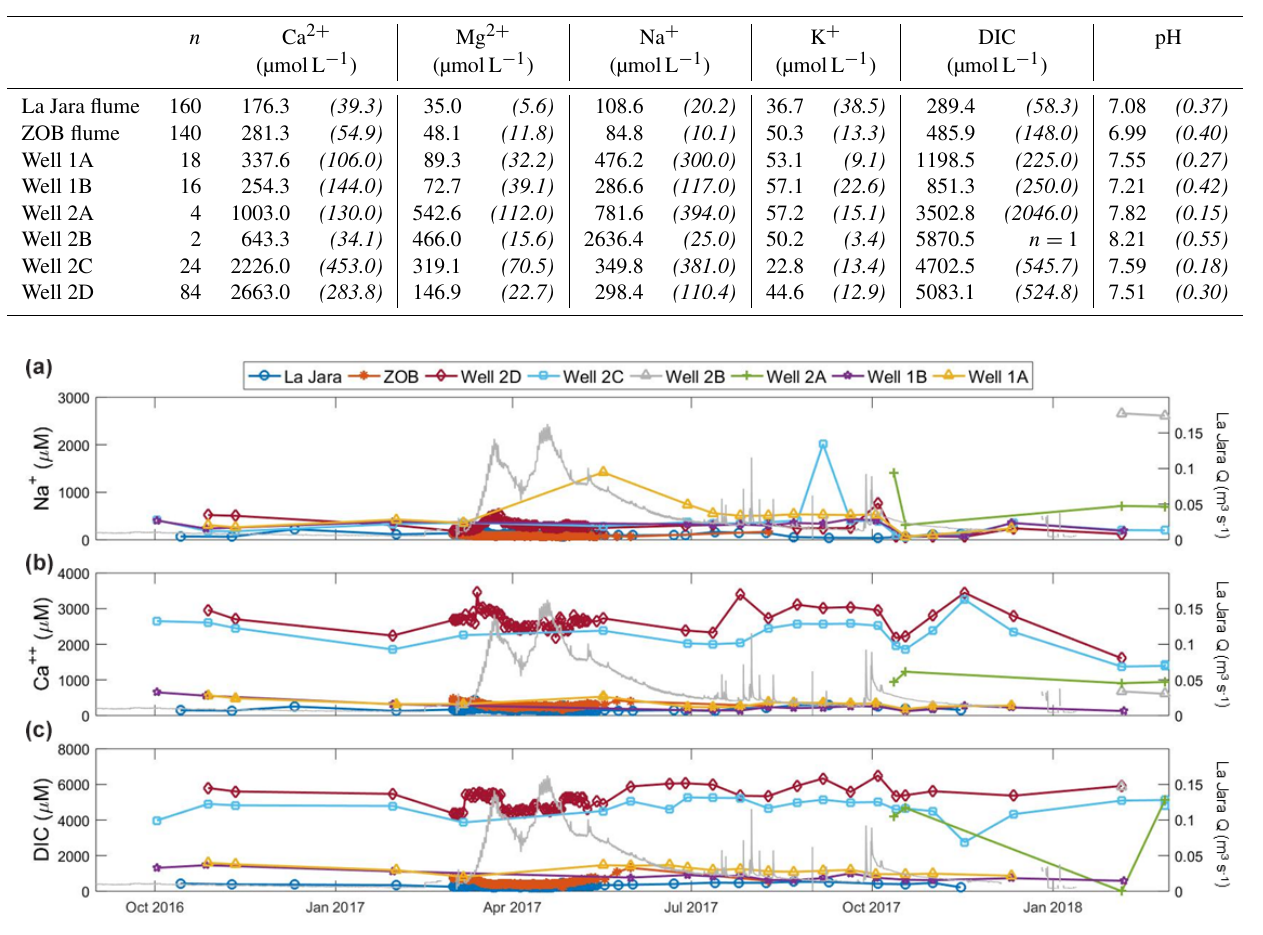
Figure 7. Time series of Na + , Ca 2 + , and DIC over WY 2017 for surface waters from La Jara flume and ZOB flume and groundwaters from sites 1 and 2. Concentrations are plotted over La Jara discharge in grey to highlight temporal